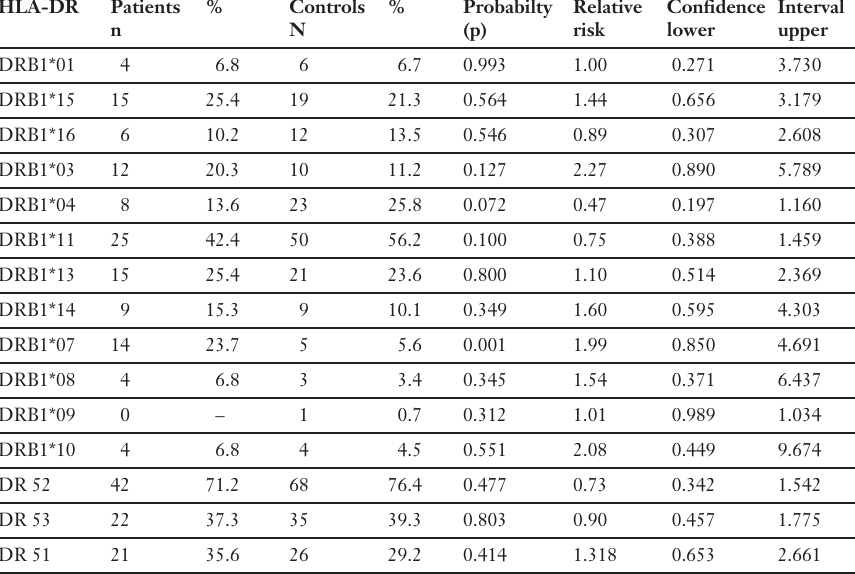
HLA-DRB1* allele distribution in controls and psoriasis vulgaris